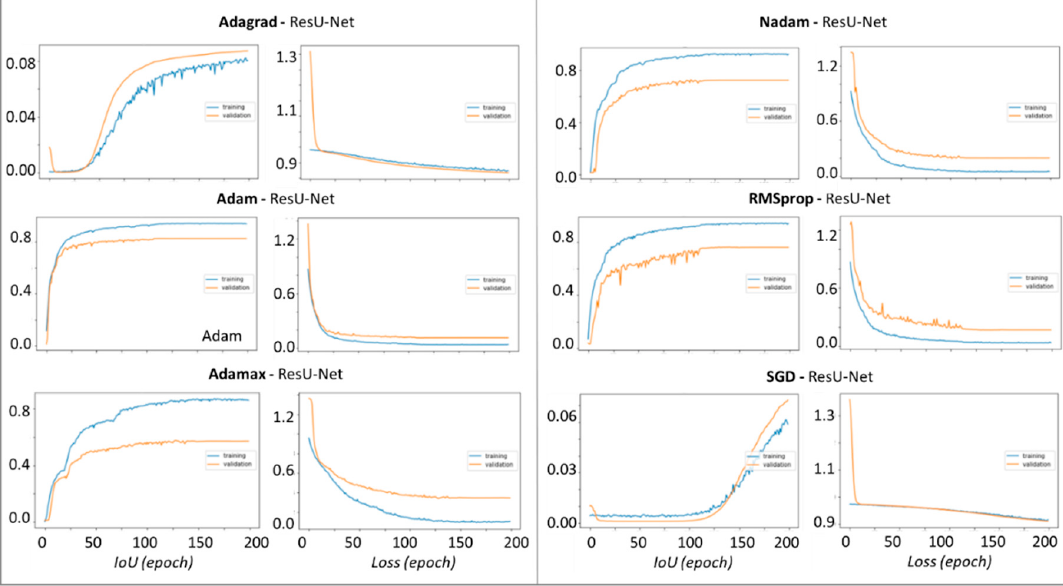
Figure 6. Fluctuation of IOU and loss function values after 200 epochs of ResU-Net models using six optimizer functions.